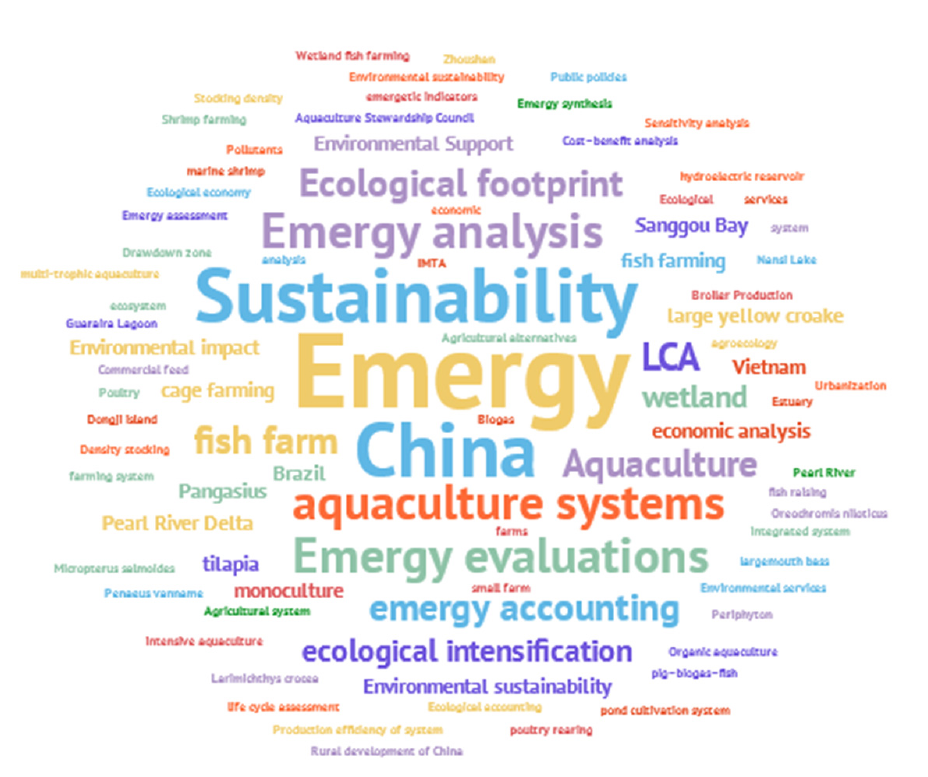
Figure 6. Keyword cloud used in selected articles. Source: elaborated by the author on the Infogrann platform.